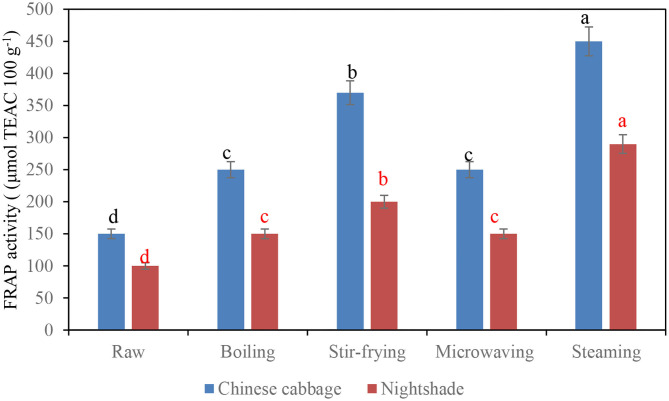
Influence of household techniques on antioxidant property (FRAP) activity of Chinese cabbage and nightshade leaves. Bars with similar alphabetic letter for a particular leafy vegetable are not significantly different at p < 0.05 according to Fisher's LSD test.